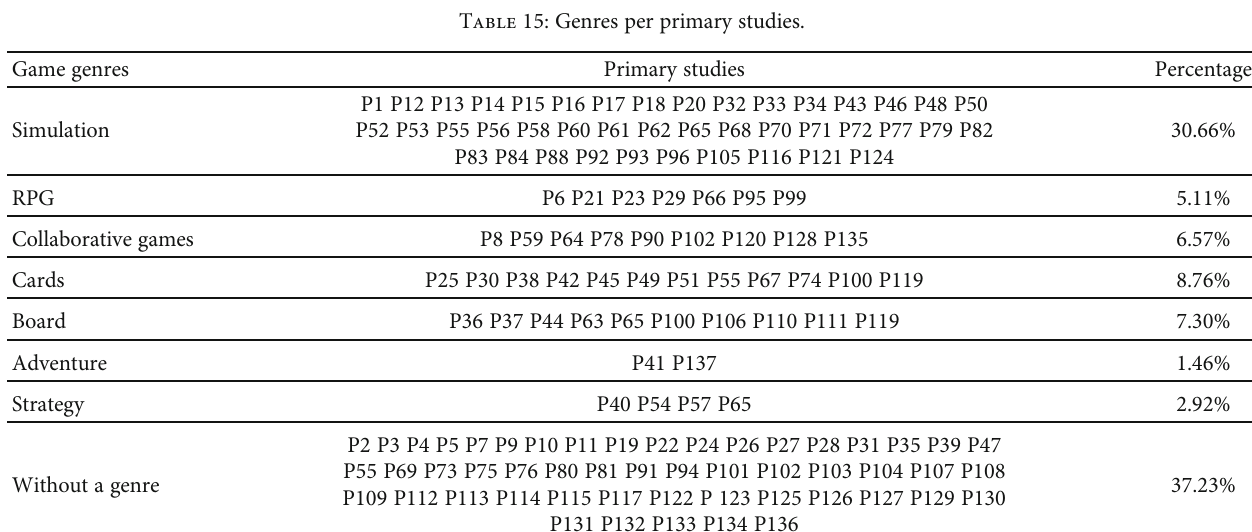
Table 15: Genres per primary studies.